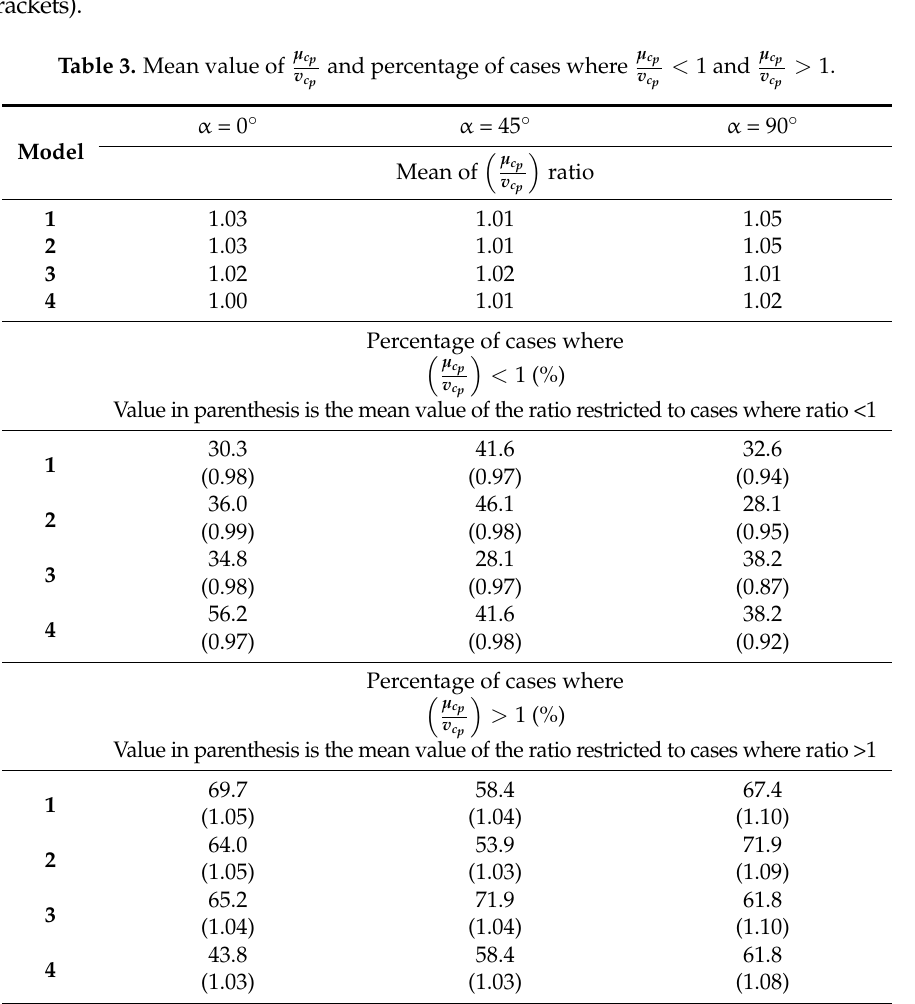
Table 3. Mean value of